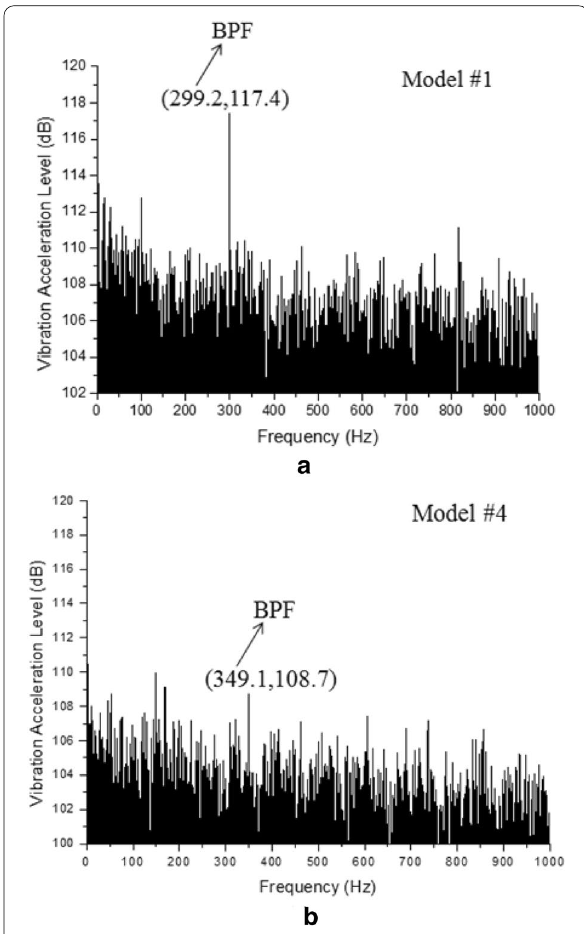
Figure 16 Spectrum of vibration acceleration level in the horizontal direction at the monitoring point: a model #1; b model